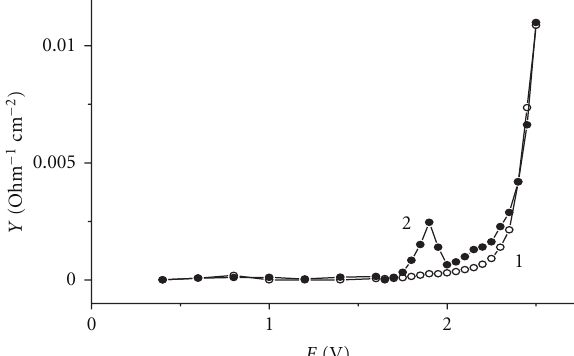
Figure 8: Potential dependence of di ff erential conductivity: (1) benzene-free solution and (2) benzene-containing